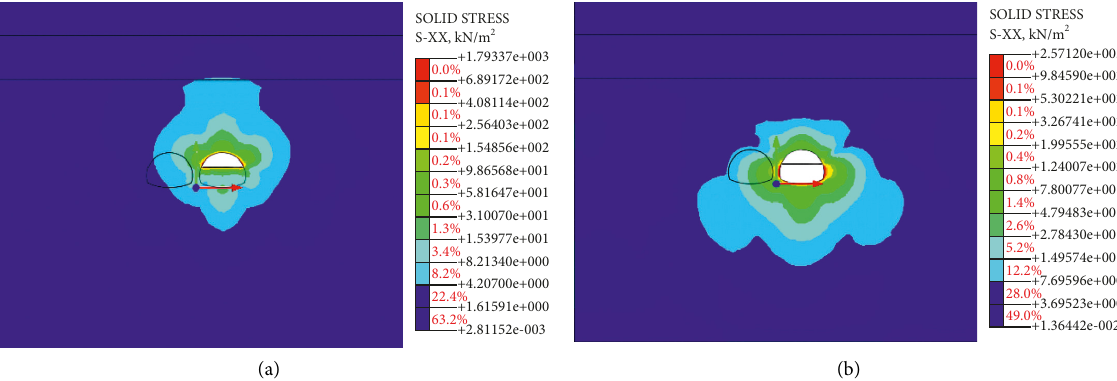
Figure 21: Stress distribution of surrounding rock (tunnel clear distance 0.15D). (a) Excavation of upper step and (b) excavation of lower step.